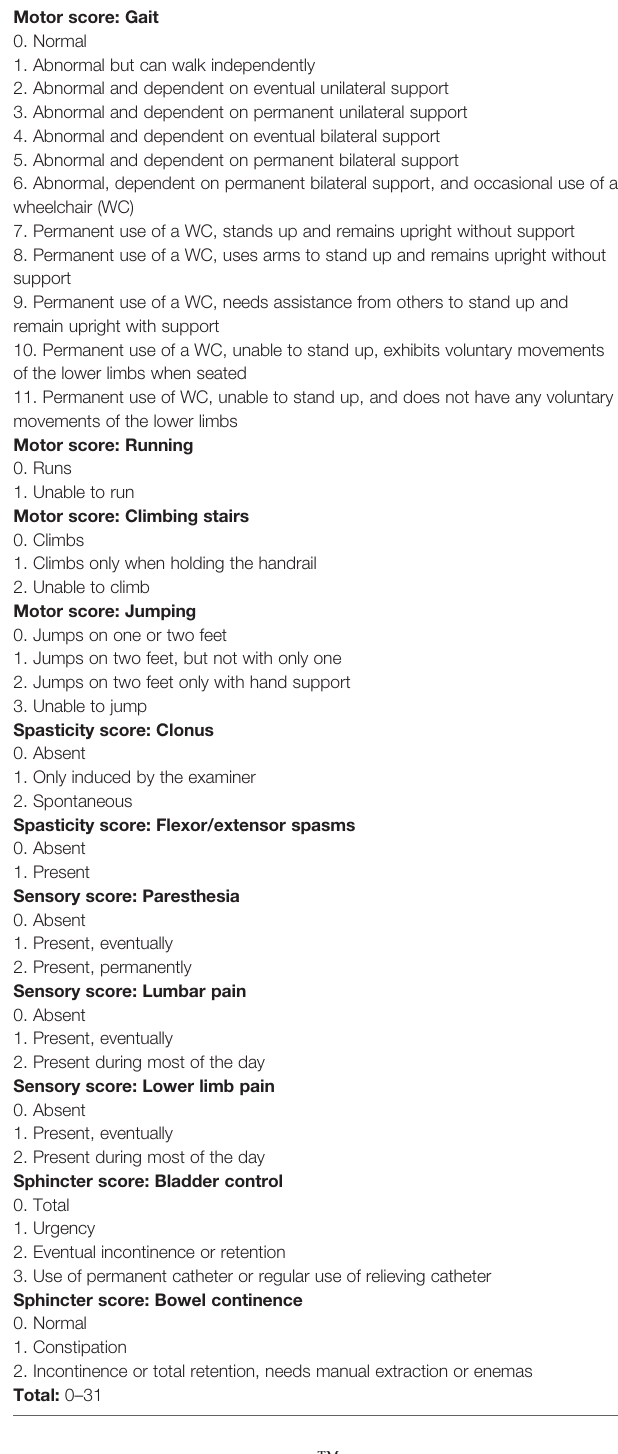
TABLE 1 | IPEC-2 disability scale. Motor score: Gait 0.